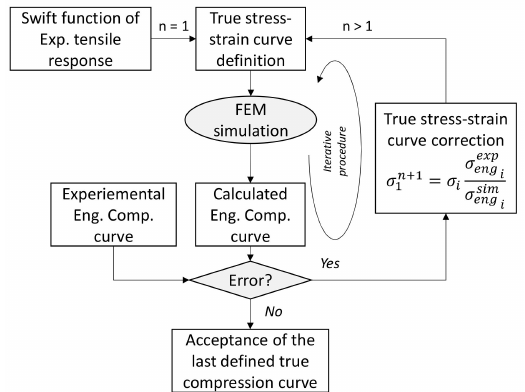
Figure 7. Flow chart of the inverse method used for the determination of the compression